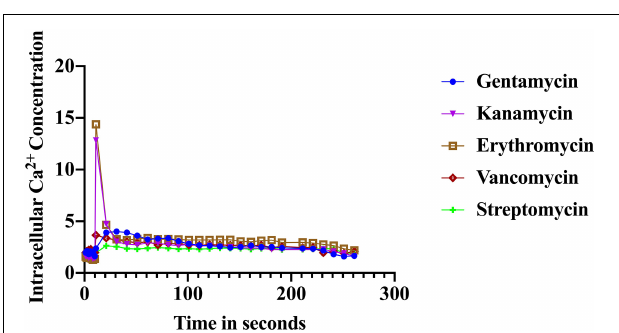
FIGURE 2 | Calcium transients in S. aureus cells induced in response to various antibiotics. The results represent the means of three separate